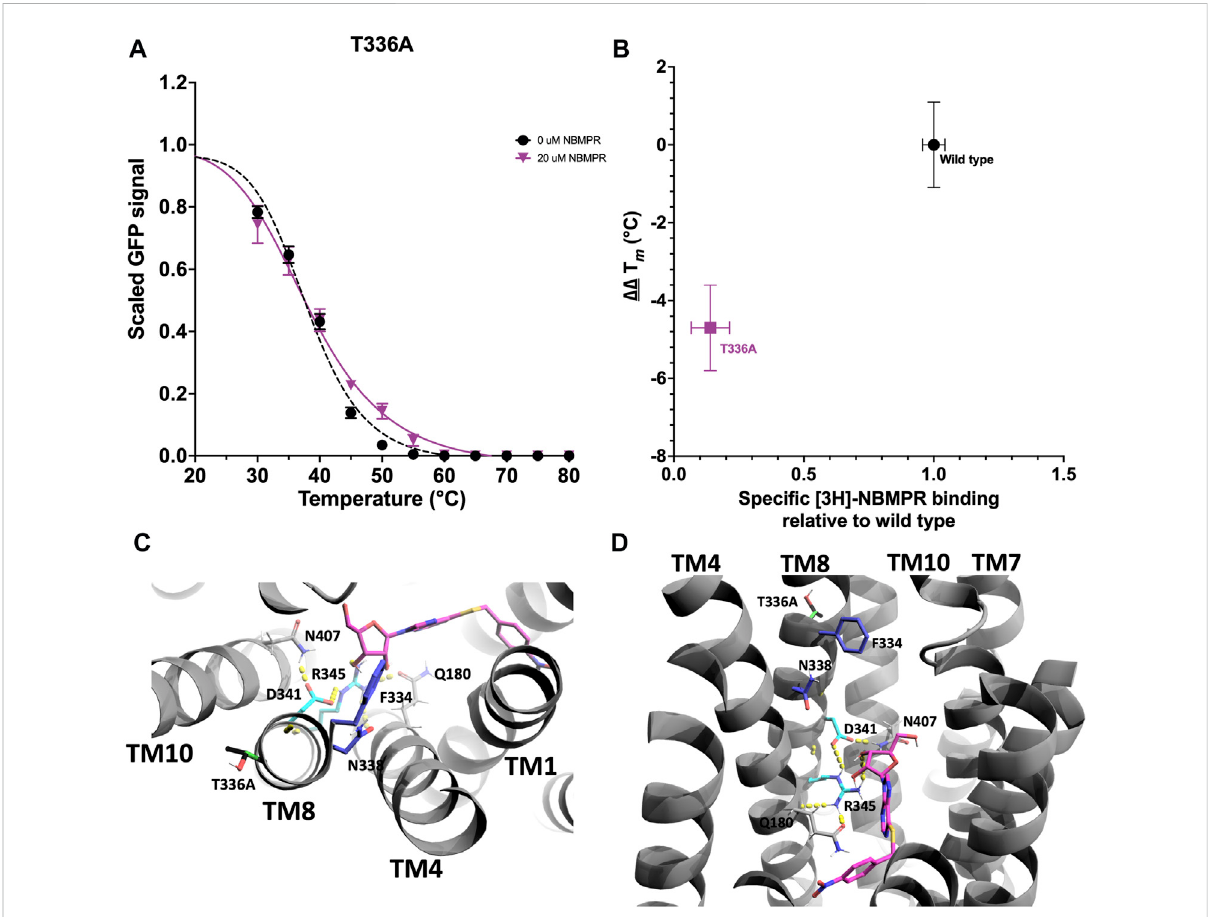
FIGURE 7 Investigation and rationalisation of variant T336A destabilisation of apo- and NBMPR bound hENT1. Data generation, fi tting and error analysis performed as detailed for wild type. (A) T336A apo -state curves were collected as an average of 12 repeats, whereas NBMPR-bound curves were collected as an average of 6 repeats. (B) Scatter plot of hENT1 variant ΔΔ T m versus amount of radiolabelled speci fi c inhibitor [3H]-NBMPR bound in the membrane, relative to wild type. Error bars are representative of error as detailed in “ Data- fi tting ” . (C) A top-down and (D) A close-up perpendicular view of the central cavity of hENT1 (TM11 is removed in D for clarity). Side chains of residues involved in the surrounding of the ribose moiety of NBMPR (pink) are shown in cyan. Residues previously determined to be important determinants in inhibitor sensitivity are shown in blue. Native T336 is shown in black, and variant T336A in